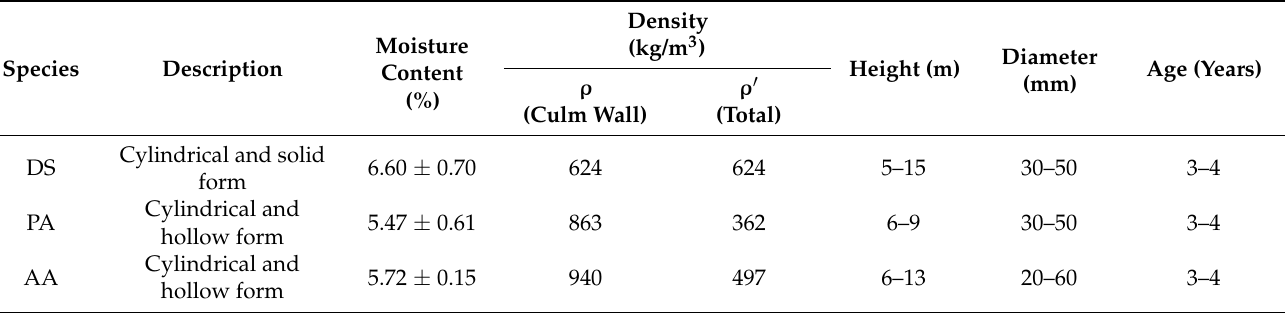
Table 2. Different characteristics of the three bamboo